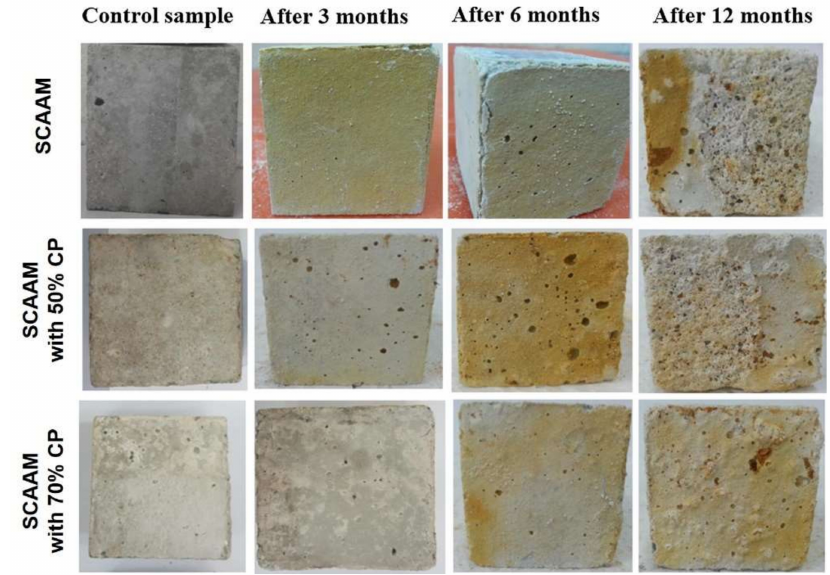
Figure 5. Photos of SCAAMs after acidic exposure (adapted from